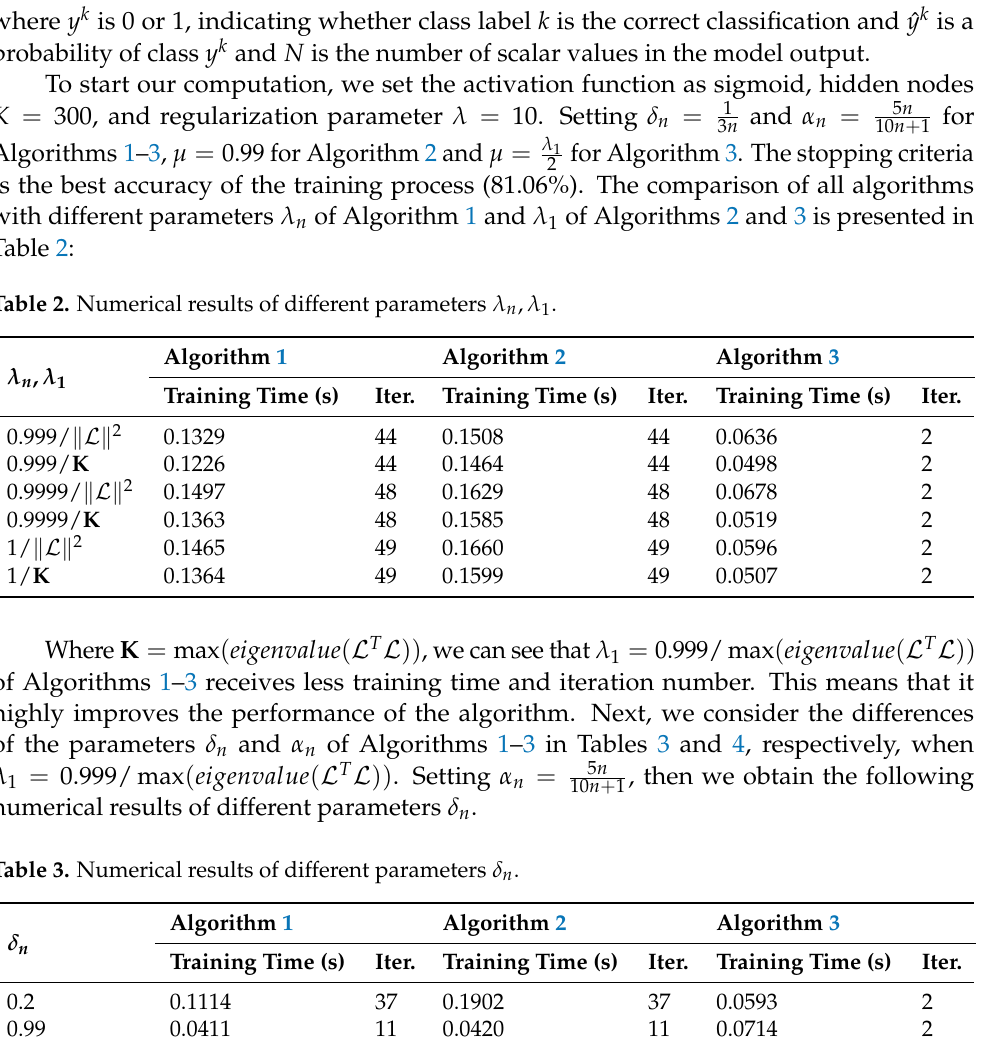
Algorithm 3 in Table 3 and setting λ 1 = 0.999/ max ( eigenvalue ( L T L )) , µ = λ 1 /2,